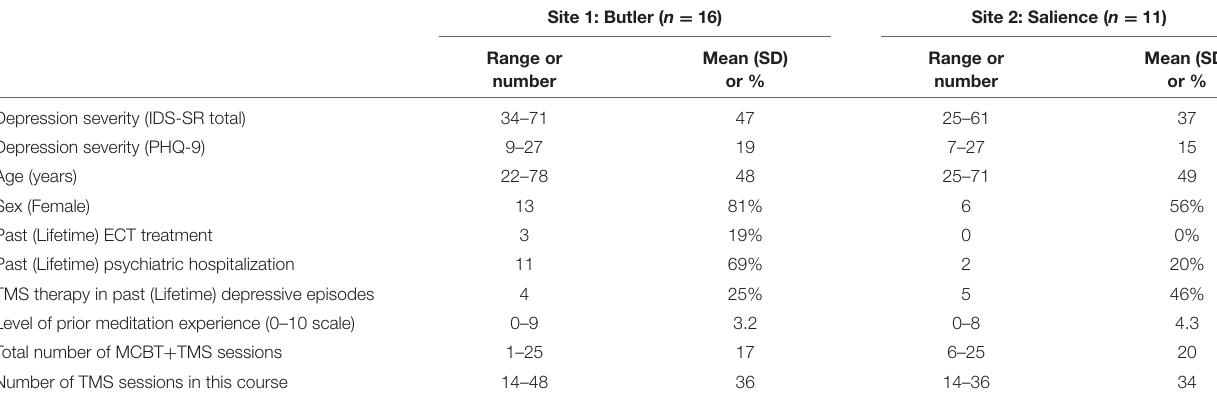
TABLE 1 | Demographic, clinical, and treatment characteristics ( n = 27).